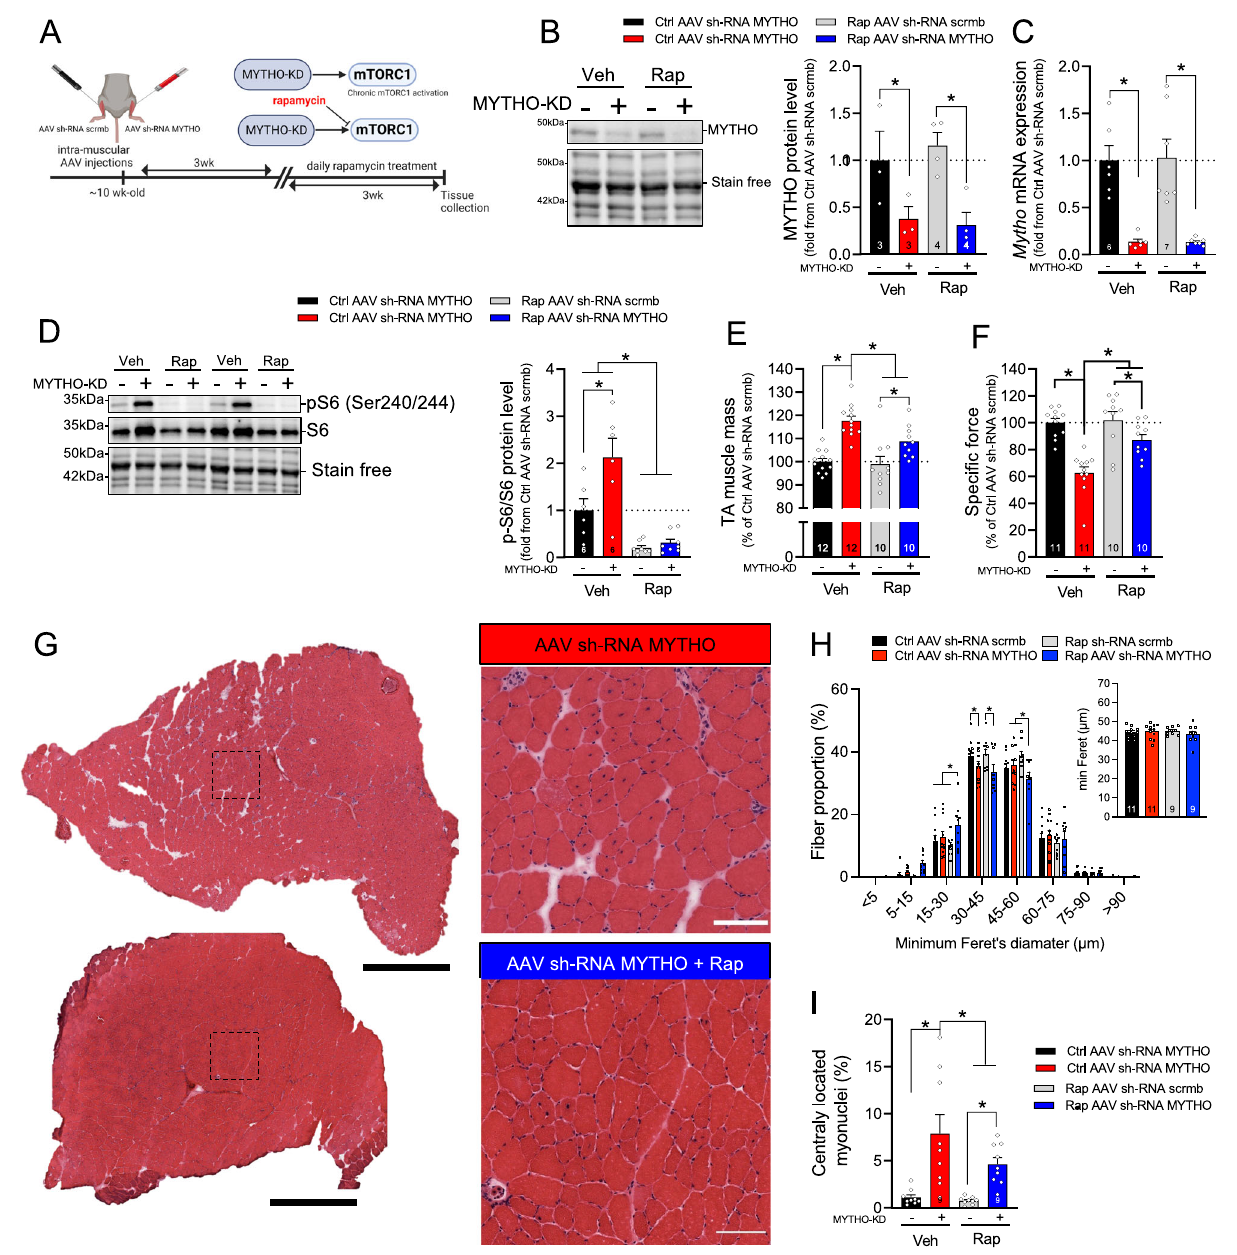
Fig. 7 | Rapamycin treatment ameliorates MYTHO knockdown (MYTHO-KD) induced myopathy. A Schematic representation of the experimental design. B Immunoblot detection and quanti fi cation of MYTHO in TA muscles from mice treatedfor 3 weekswith rapamycin (Rap) or vehicle at3 weeks post AAV-mediated transduction. C Quanti fi cation of Mytho mRNA expression in muscle assessed by RT-qPCR. Data were normalized by the geometric mean of 18S , β -Actin, and Cyclophilin . D Immunoblots detection and quanti fi cation of pS6 and totalS6 in TA muscles demonstrating mTORC1 inhibition in mice treated with rapamycin. E TA muscle mass from mice treated with vehicle or rapamycin 6 weeks post AAV- mediatedtransduction. F insituassessmentofmuscle-speci fi cforceinAAVsh-RNA scramble and AAV sh-RNA MYTHO injected TA muscles from mice treated with